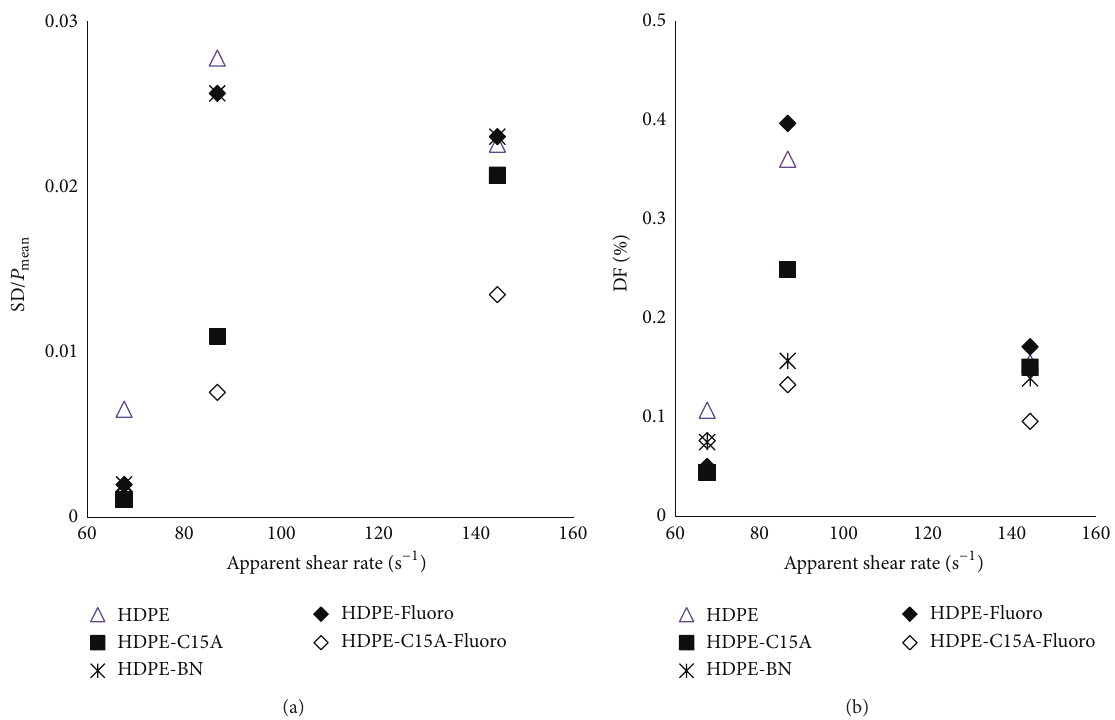
Figure 13: (a) Ratio of standard deviation and the mean pressure. (b) Distortion factor as a function of apparent shear rate for HDPE, HDPE- C15A, HDPE-BN, HDPE-Fluoro, and HDPE-C15A-Fluoro at transducer 3